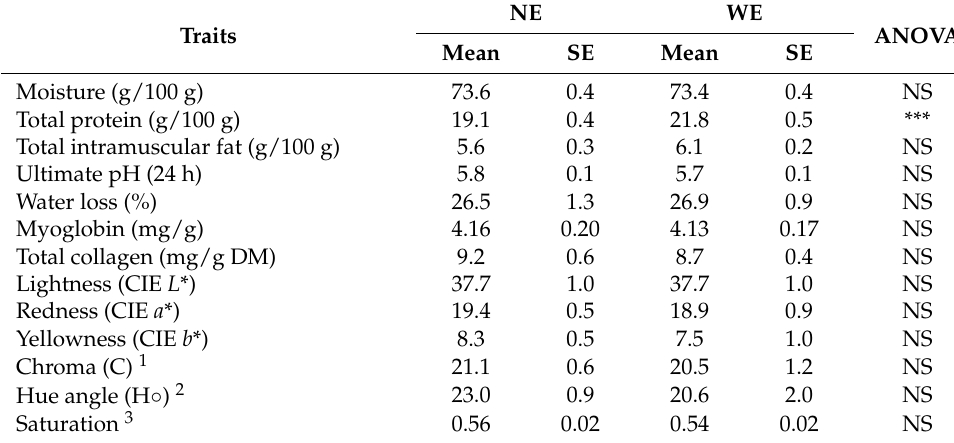
Table 8. Physical-chemical composition of psoas major from Alentejano pigs kept on individual pens without exercise area (NE, n = 9) or outdoors with exercise area (WE, n = 9) from ~87 to 160 kg BW. Traits